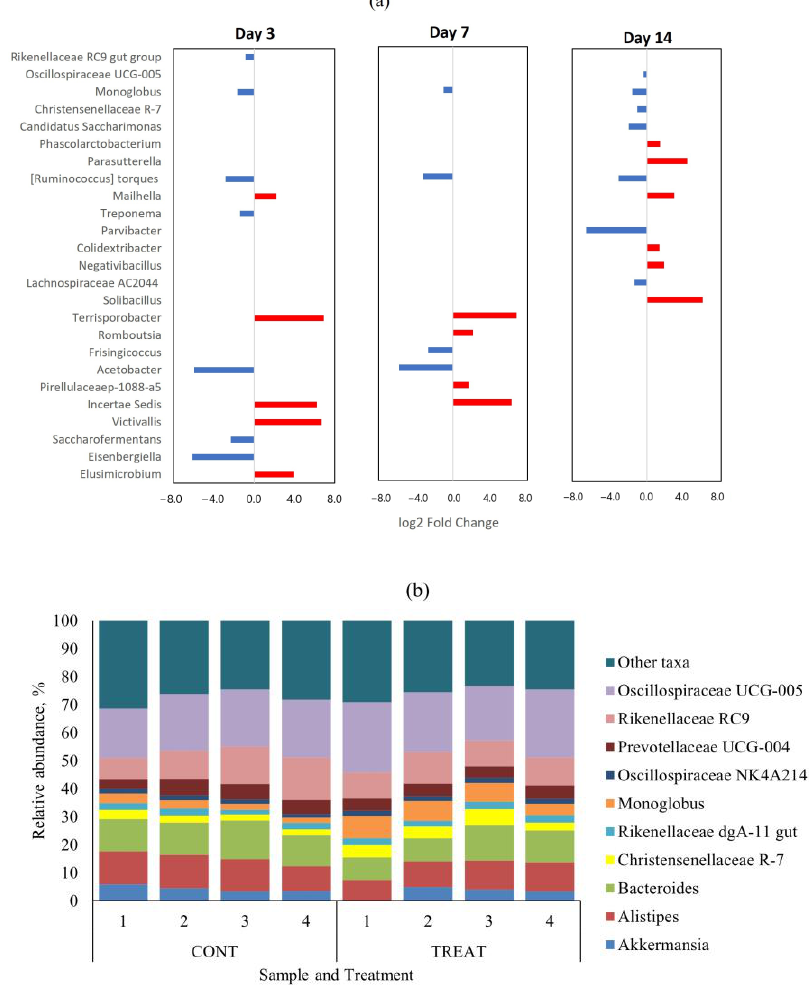
Figure 3. ( a ) Differentially abundant ( p < 0.05) genera in the fecal microbiome between control (CONT) and oxytetracycline hydrochloride-exposed (TREAT) cattle 3, 7, and 14 days after antibiotic treatment. Taxa in the y-axis are ordered from most abundant (top) to lower abundant (bottom) genera. Negative (blue) and positive (red) log 2 fold change values within days are genera enrichments in TREAT and CONT samples, respectively. ( b ) Relative abundance of top-10 genera on day 14 separated by treatment.